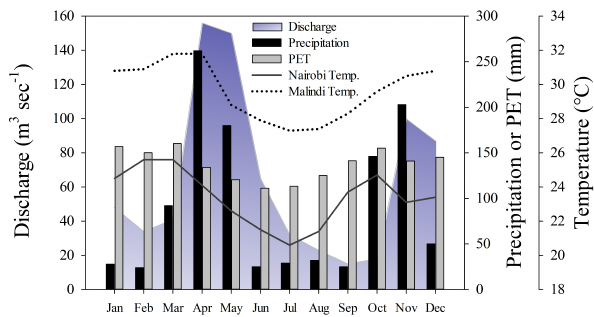
Fig. 2. Mean monthly variation of hydrological and climate pa- rameters in the Athi–Galana–Sabaki catchment, including discharge at the outlet (shaded area; data from 1959–1977), precipitation (black bar) (from Fleitmann et al., 2007), potential evapotranspira- tion (PET; grey box), and the maximum air temperature in Nairobi (A-G-S headwaters; solid grey line) and Malindi (A-G-S outlet; dot- ted black